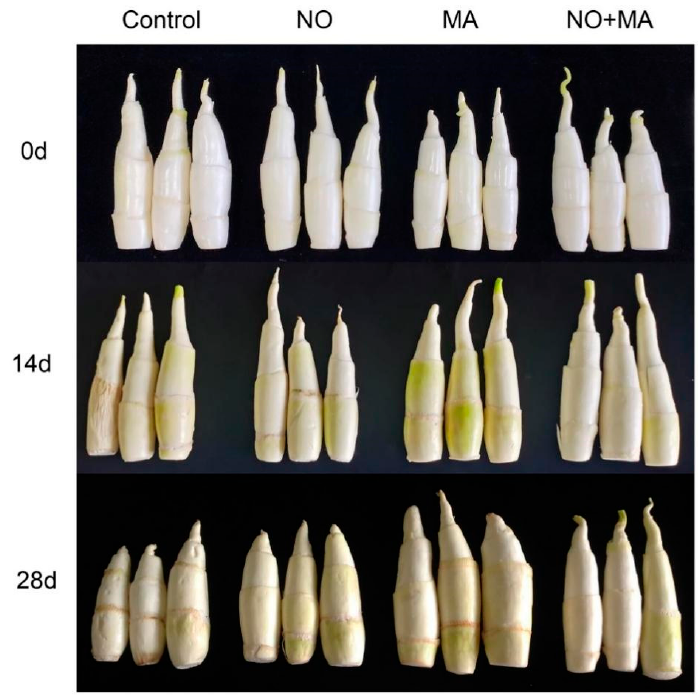
Figure 1. Effects of NO and MAP treatment on the color and skin-wilting of water bamboo shoot stored at 4 °C for 0, 14, and 28 d.